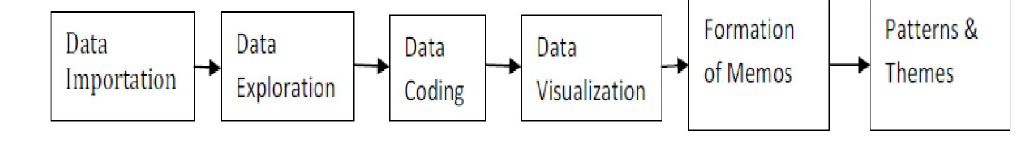
Fig 1. Data analysis leading to theme